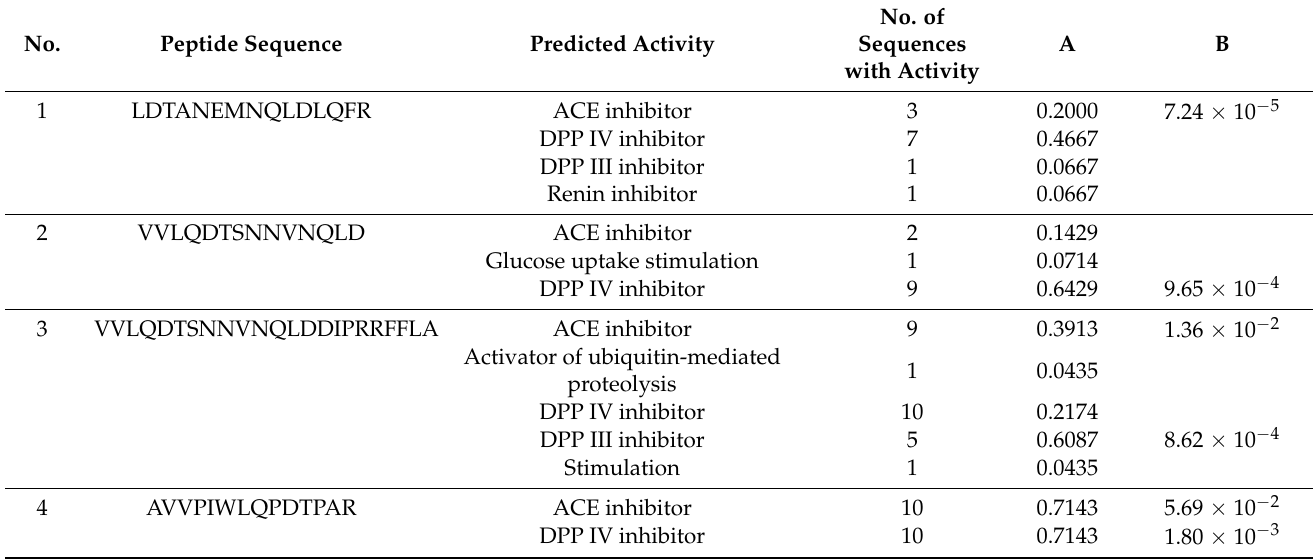
Table 4. Predicted activity of VOO endogenous peptides identified by Peaks DB using BIOPEP-UWM database of bioactive peptides: ACE, angiotensin-converting enzyme; DPP III, dipeptidyl peptidase- III; DPP IV, dipeptidyl peptidase-IV; A, ratio of number of sequences with predicted activity to number of amino acids; B, potential biological activity of the peptide ( µ M − 1 ) theoretically calculated from previous bioactive referenced data. A and B values obtained from BIOPEP-UWM